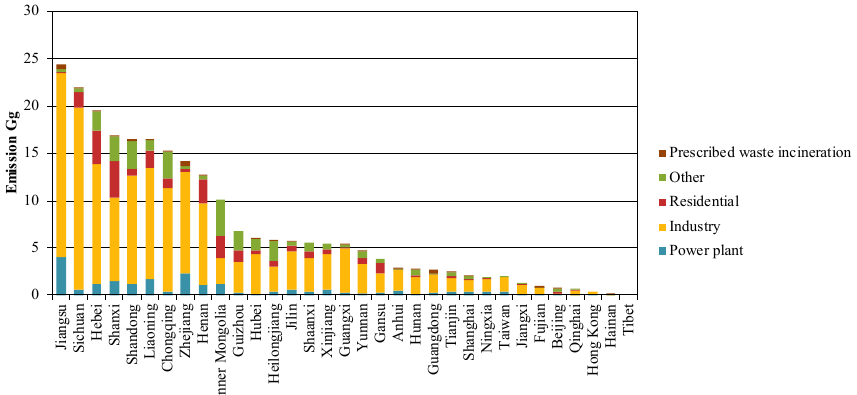
Figure 2. The HCl emission in the study region in 2012 from four economic sectors of coal combustion and from prescribed waste incinera-